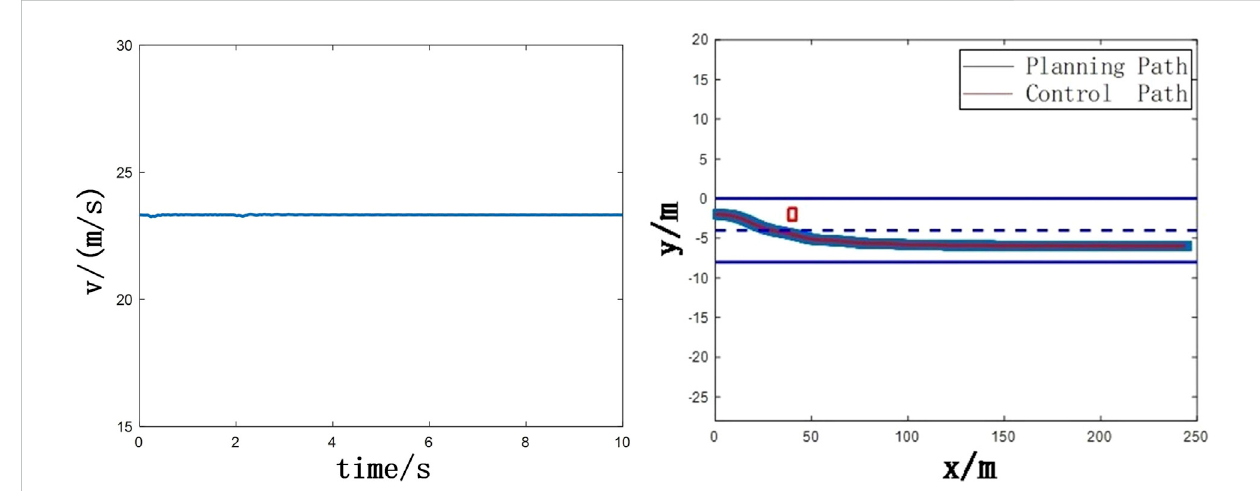
FIGURE 9 (A) Ego vehicle speed (B) Obstacle avoidance trajectory.